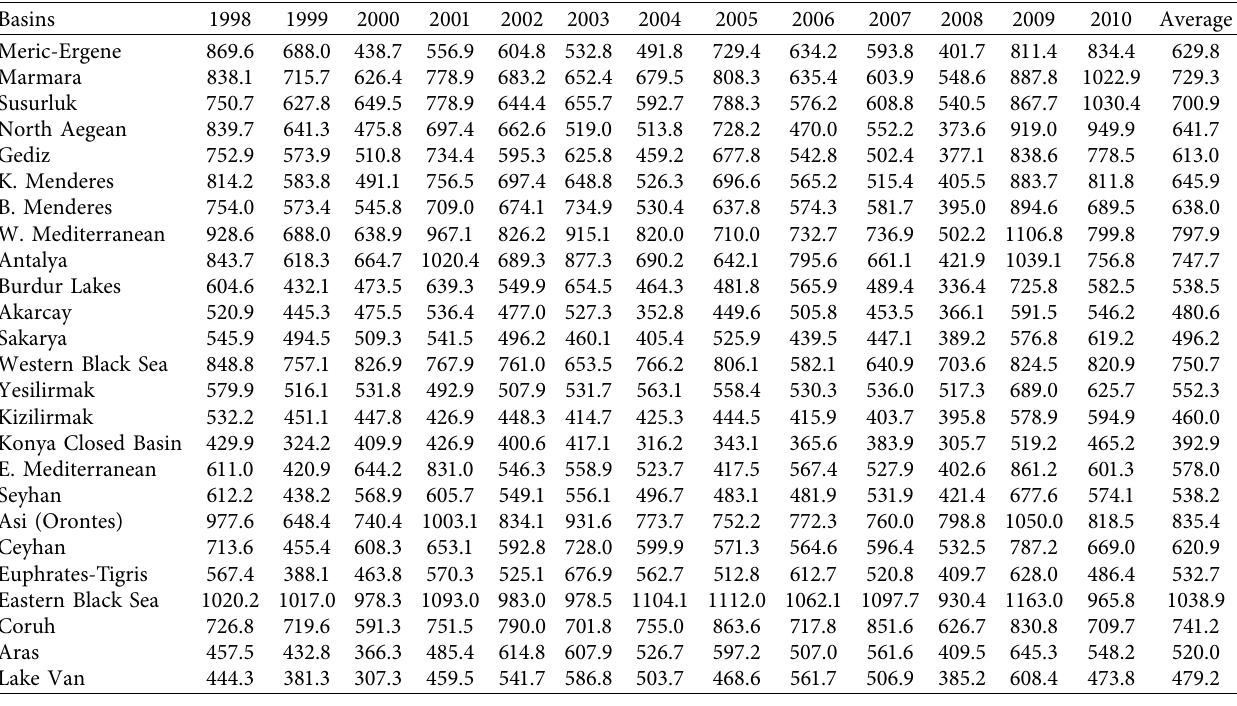
Table 3: Average precipitation (mm) for the years 1998–2010 [19].